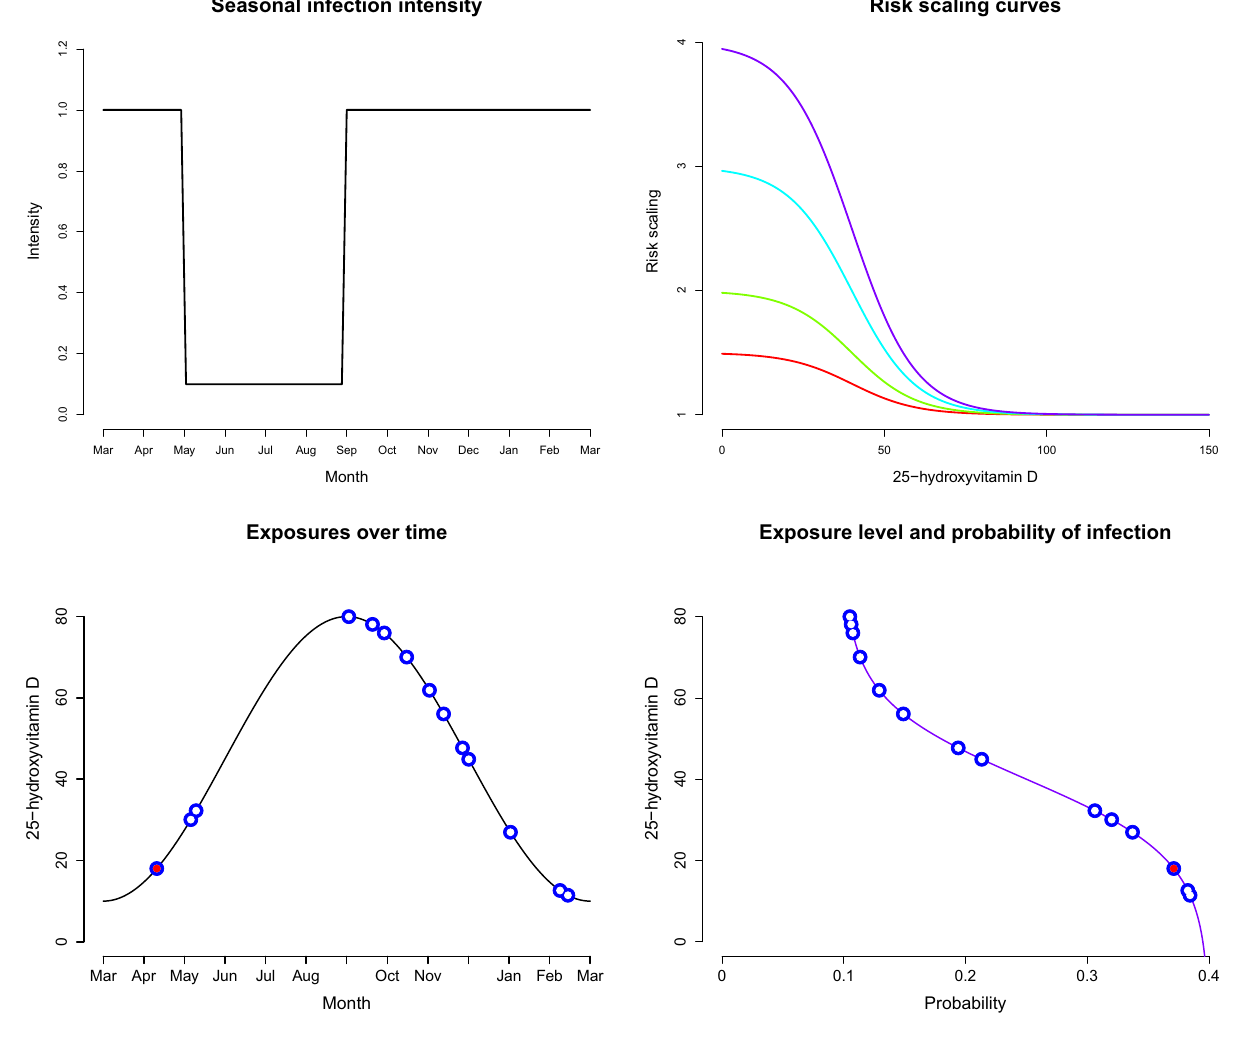
Figure 2. Top row left: intensity function for a seasonal infection shown in units of exposures per week. Top row right: generalised logistic curves giving the risk scalings for l = 1 and u = 1.5, 2, 3, 4 . Bottom row left: example of an individual’s exposures shown in blue, with red centre indicating an infection developed following exposure. Bottom row right: corresponding 25OHD status at exposure, shown as a function of the probability of infection for that status